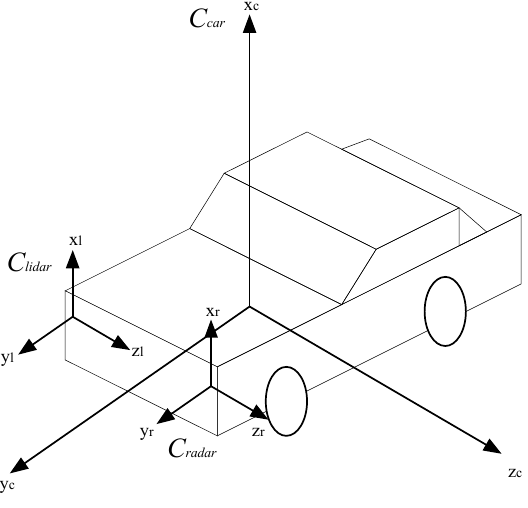
Figure 2. The relations among C lidar , C radar , and C car .